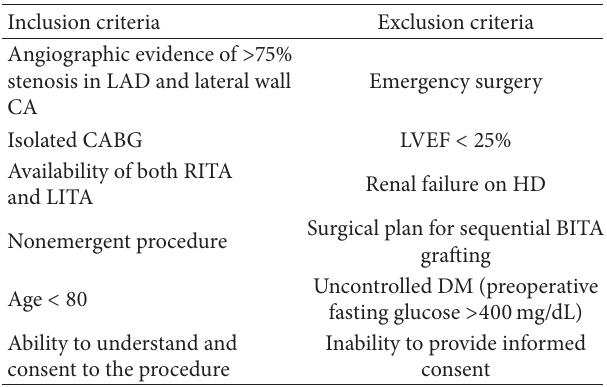
Table 1: Inclusion and exclusion